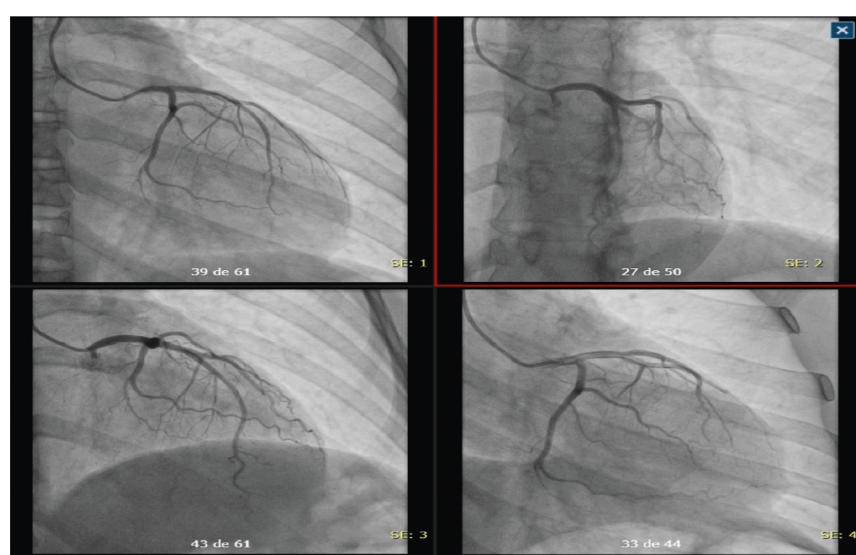
Figure 5: Coronary arteriography.